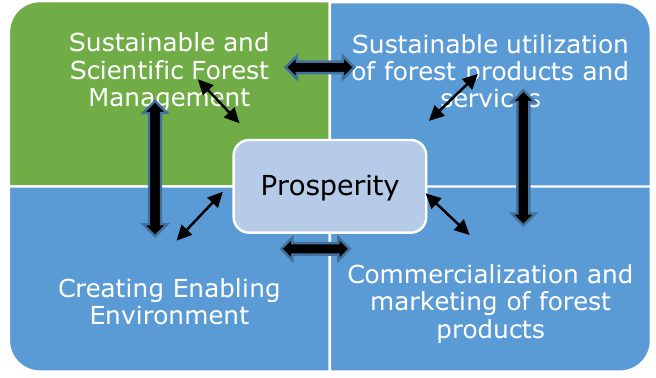
Figure 1. Four pillars of “Forestry for prosperity” (Adapted from Paudel, 2017 [13]).